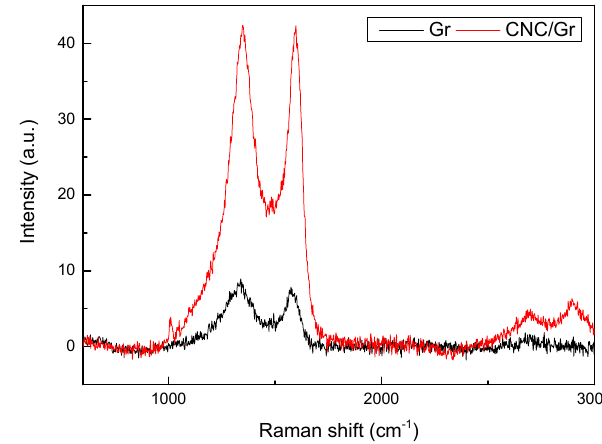
Figure 3. Raman spectrum of graphene materials and CNC / GM sol mixtures containing 2 wt % of GM.